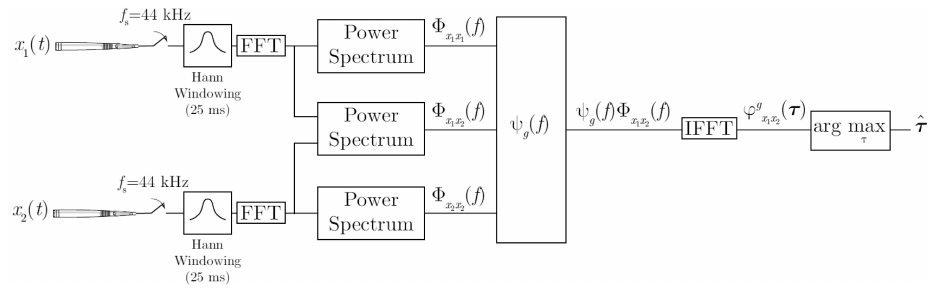
Figure 1. Block diagram for PHAT (phase transform).